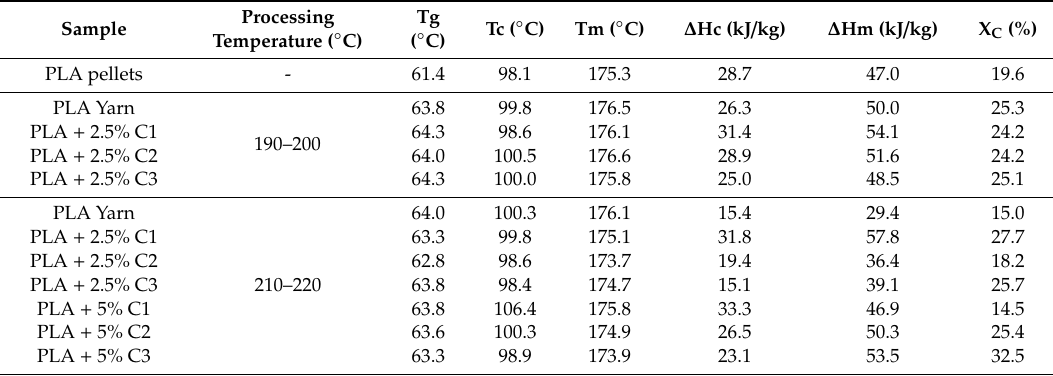
Table 4. Transition temperatures, (glass transition temperature T g , crystallization temperature T c and melting temperature T m ), enthalpies and crystallinity degree of the extruded PLA samples after di ff erent conditions of processing obtained from the second heating cycle with a rate of 10 ◦ C /